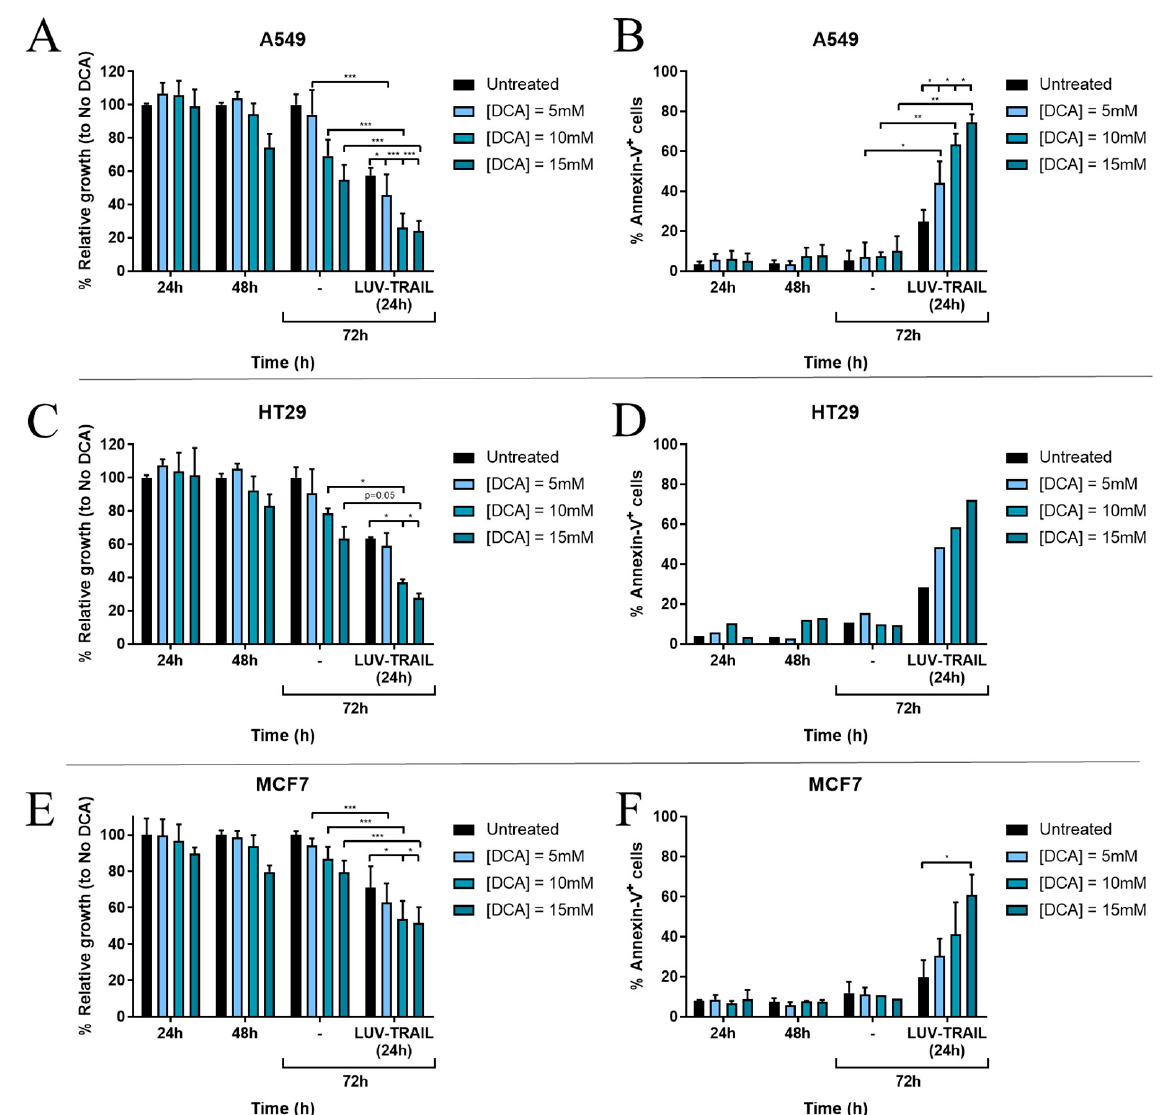
Figure 2. Effect of DCA + LUV-TRAIL (LT) combination in cell growth (MTT assay) and cell death (annexin-V staining and detection by flow cytometry) in ( A , B ) A549, ( C , D ) HT29, and ( E , F ) MCF7 cells. Tumor cells were incubated with DCA (5–15 mM) for several time points. After 48 h, cells were added LT (1000 ng/mL) for another 24 h. Results are displayed as mean +/ − SD of n = 1–6. * p < 0.05; ** p < 0.01; *** p < 0.001.